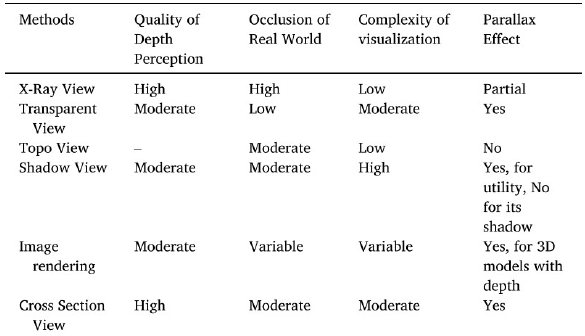
Table 1. Comparison of AR visualization methods for subsurface utilities (Muthalif et al., 2022).